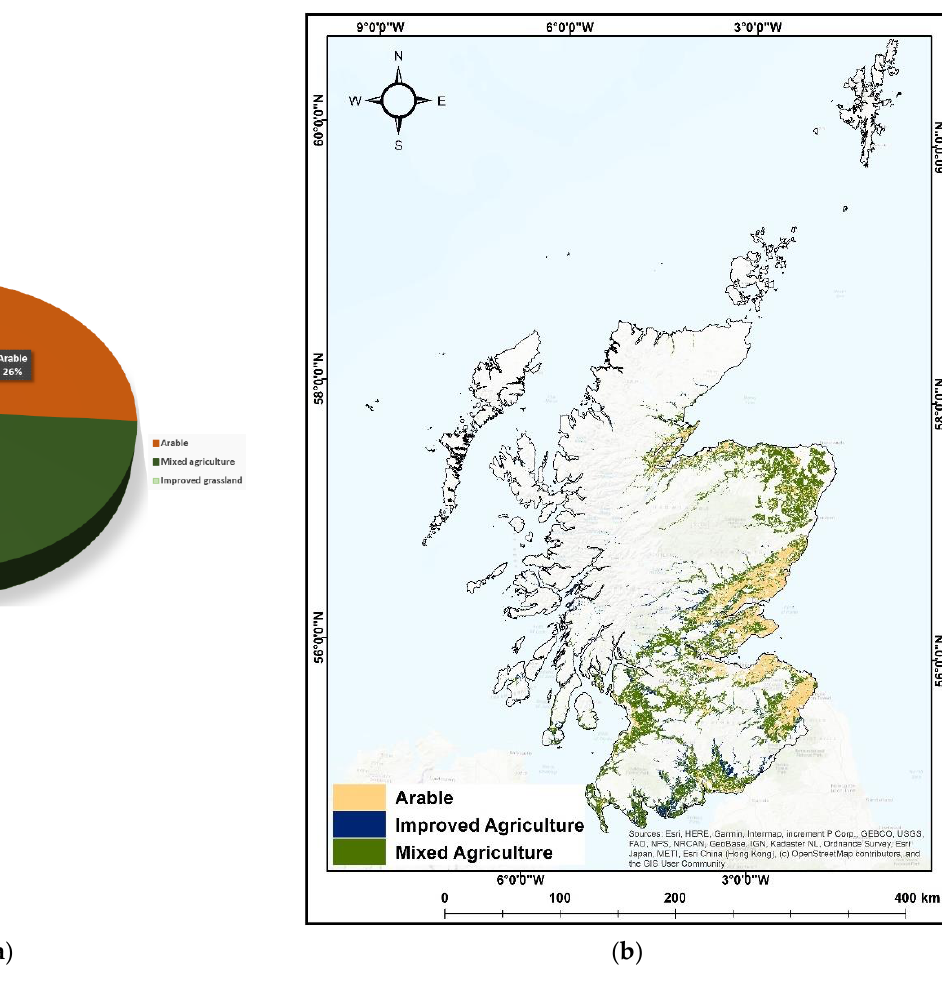
Figure 7. ( a ) The percentage of suitable land for Sitka spruce that fall in each LCA class. ( b ) Map showing suitable land for Sitka spruce in the three LCA classes. Table 10. Area and percentage of suitable for afforestation with Sitka spruce in each LCA class. LCA